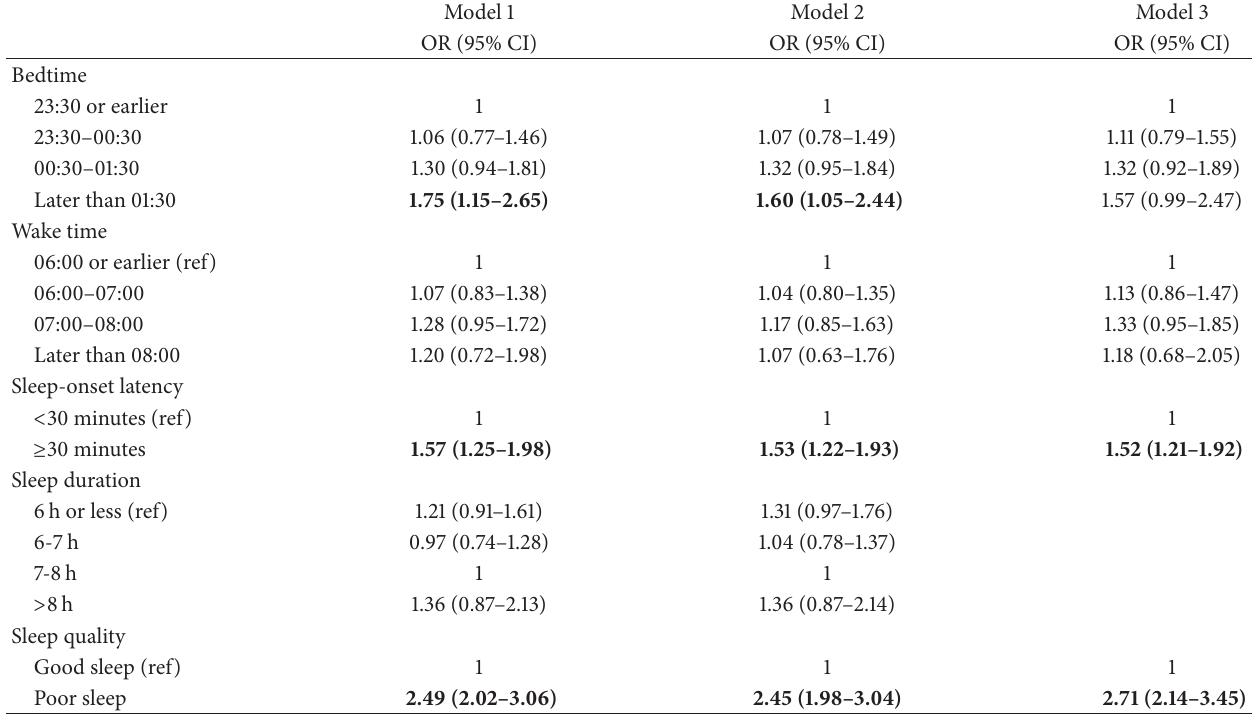
Table 3: Association between sleep behaviours and depressive symptoms according to multinominal logistic regression